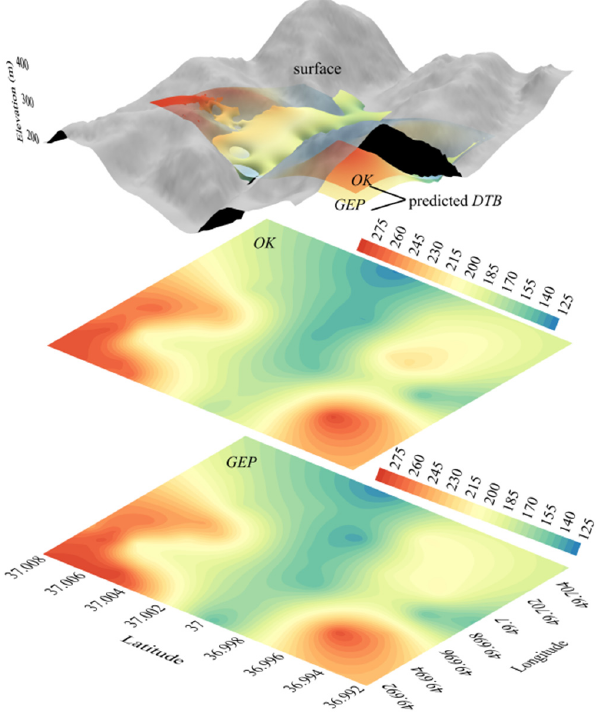
Figure 11. Visualized insights into predicted spatial DTB models using optimum GEP and OK . The performance of predictive model including quantitative numerical values can be scaled and compared using statistical error metrics such as mean absolute percentage error ( MAPE ), RMSE , R 2 , and residuals. The MAPE is one of the most popular indexes for description of accuracy and size of the forecasting error, while residual represents a fitting deviation of predicted value from measured. RMSE expresses the prediction accuracy of a model and is an appropriate estimator for the standard deviation of the error distribution. R 2 reflect the goodness of fit in prediction problem. As presented in Figure 12, higher values of R 2 as well as smaller MAPE , residual, and RMSE are interpreted as more accurate levels (Figure 11).